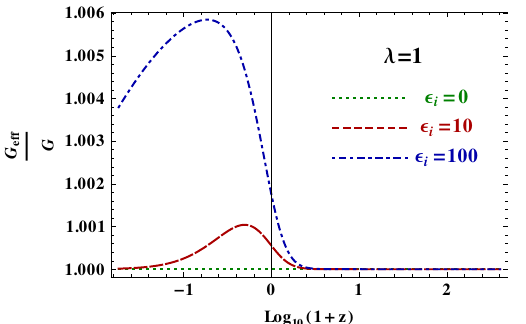
Figure 3. Evolution of G eff has been shown. Green (dotted), red (dashed), and blue (dot-dashed) curves correspond to (cid:101) i = 0, 10, 100 respectively for the exponential potential with slope λ =